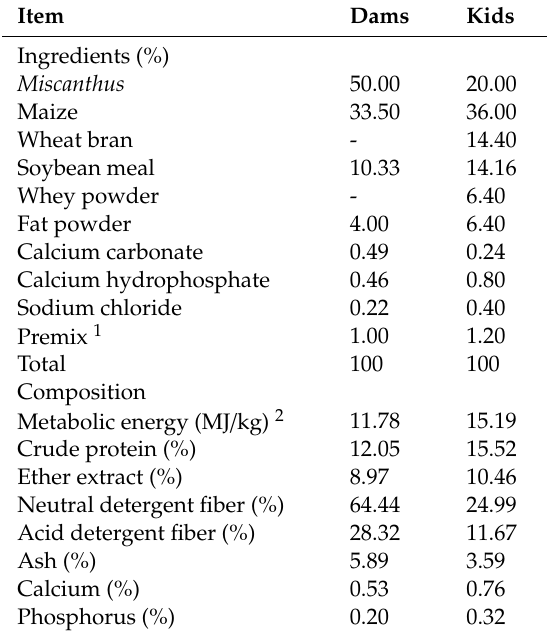
Table 1. Ingredients and composition of the experimental diets for dams and kids (DM basis). Item Dams